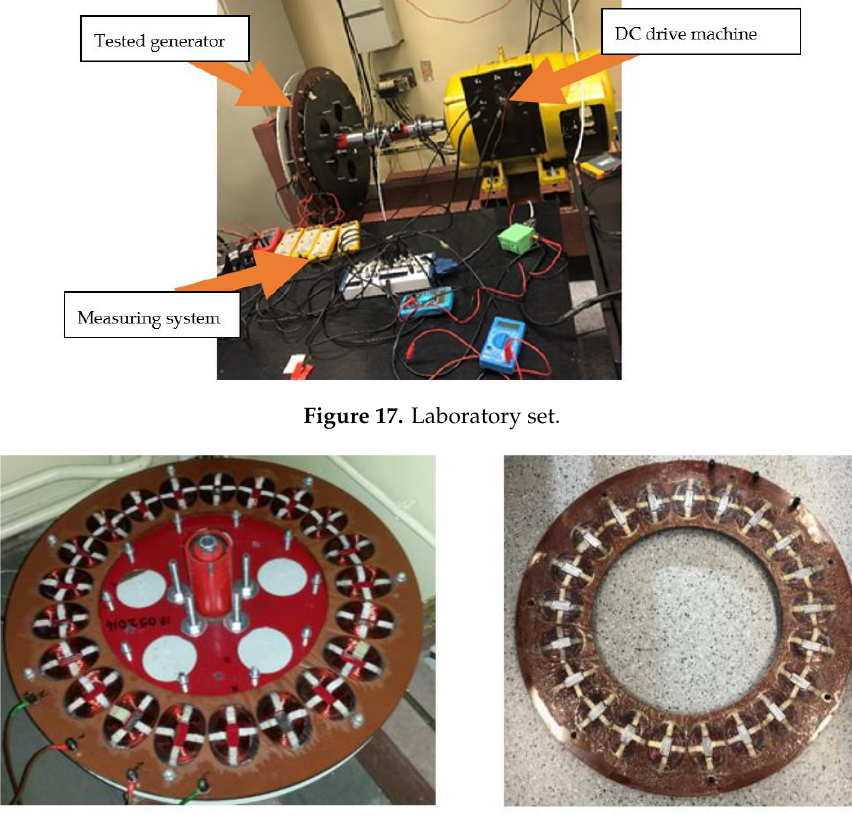
Figure 18. Stator Figure 18. Stator disk.